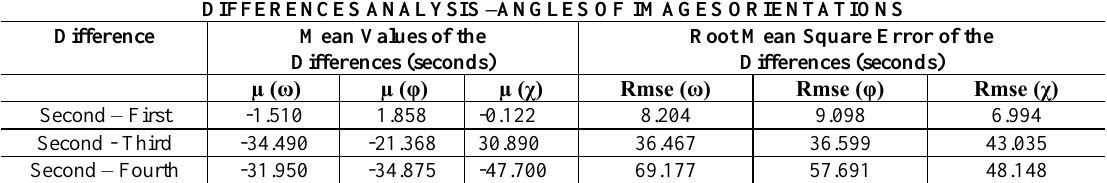
Table 7. Main results of the analysis of angles of images orientation performed in the in situ self-calibration